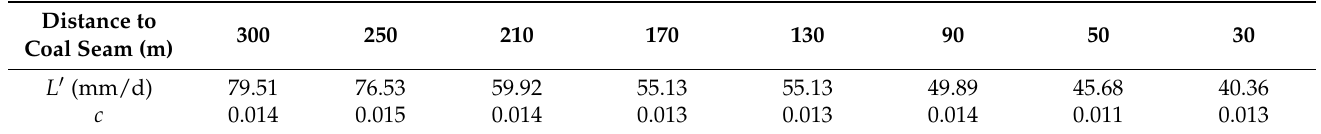
Table 3. The LDMSV parameter of the overlying